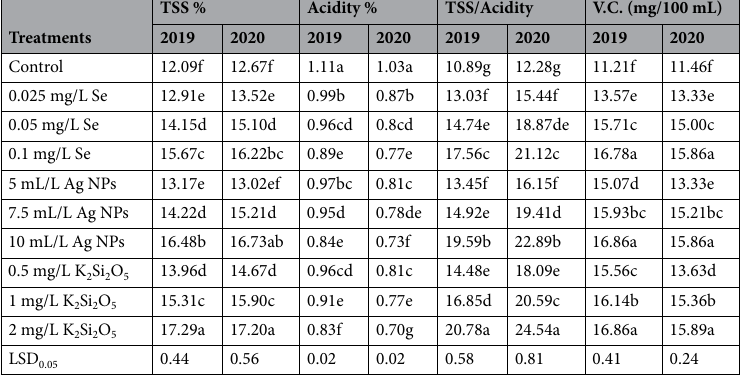
Table 7. Influence of the foliar spraying of Se, Ag NPS and K 2 Si 2 O 5 on fruit content from TSS, acidity, TSS/ acidity ratio, and V.C. of pomegranate cv. Succary during 2019 and 2020 season. Means not sharing the same letter(s) within each column are significantly different at 0.05 level of